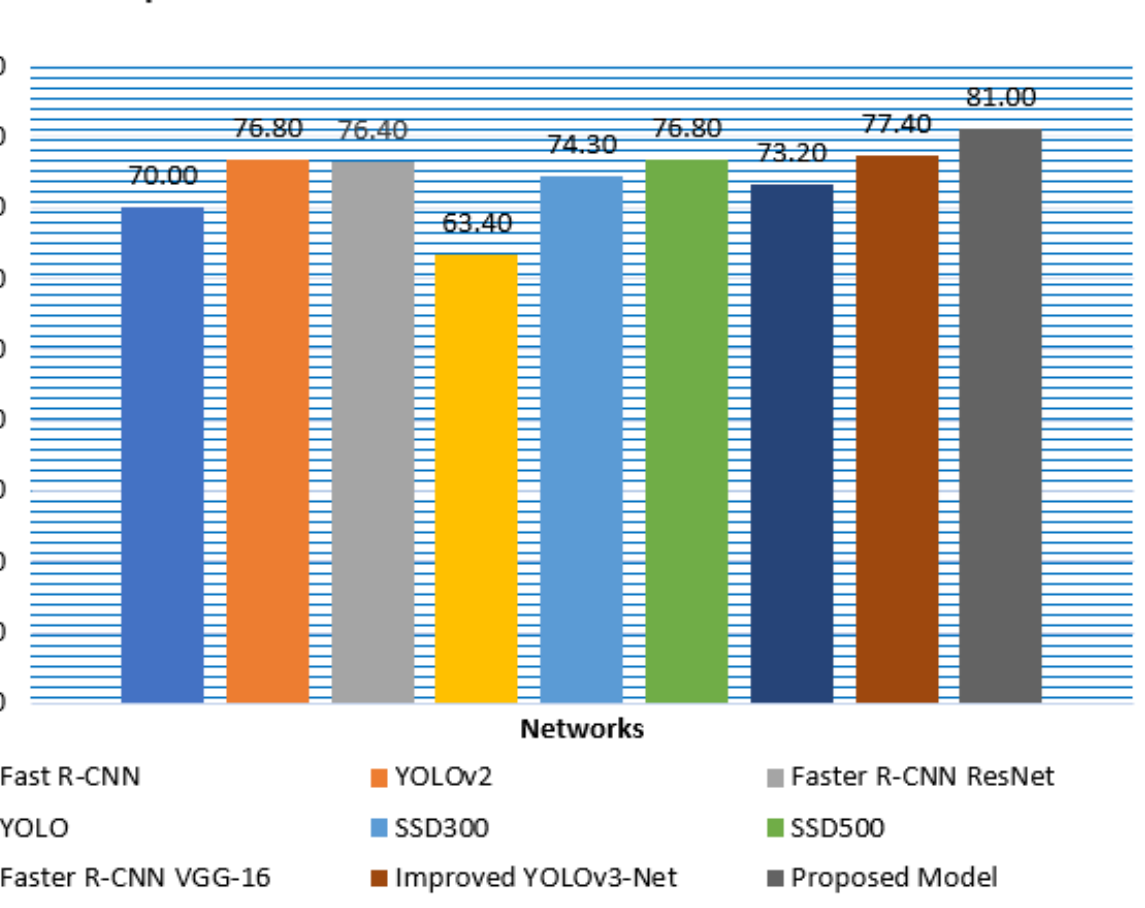
Figure 8. Comparison of mAP between the different networks with the proposed network.